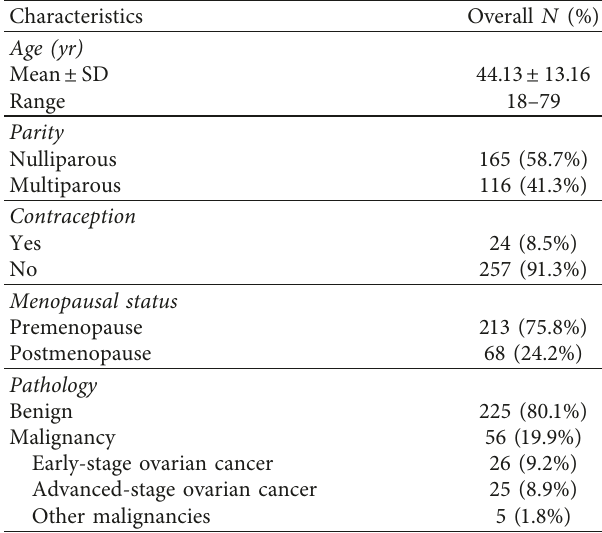
Table 1: Patients’ characteristics and pathologic results of the ovarian